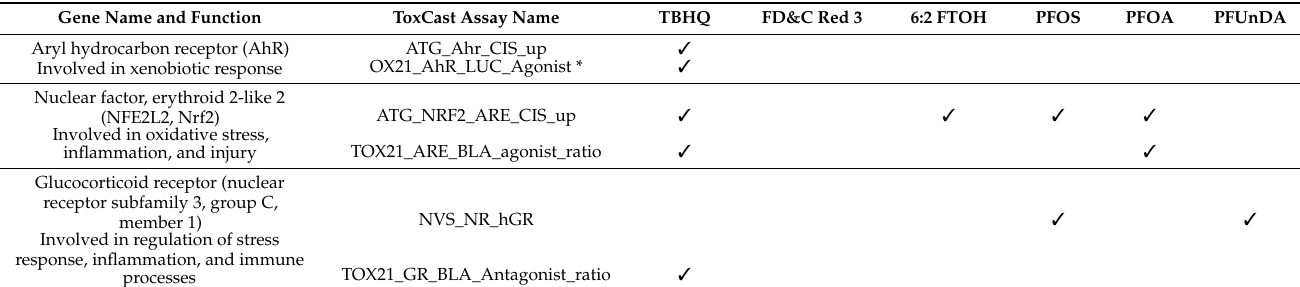
Table 5. Transcription factors affected by tert-butylhydroquinone and other compounds in ToxCast assays. Gene Name and Function